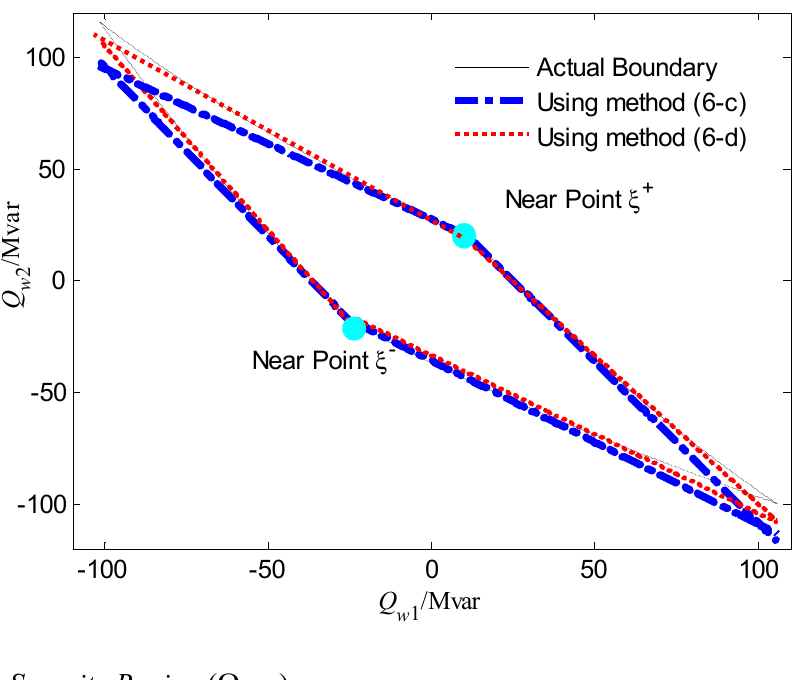
Figure 9. Comparison of the techniques of Figure